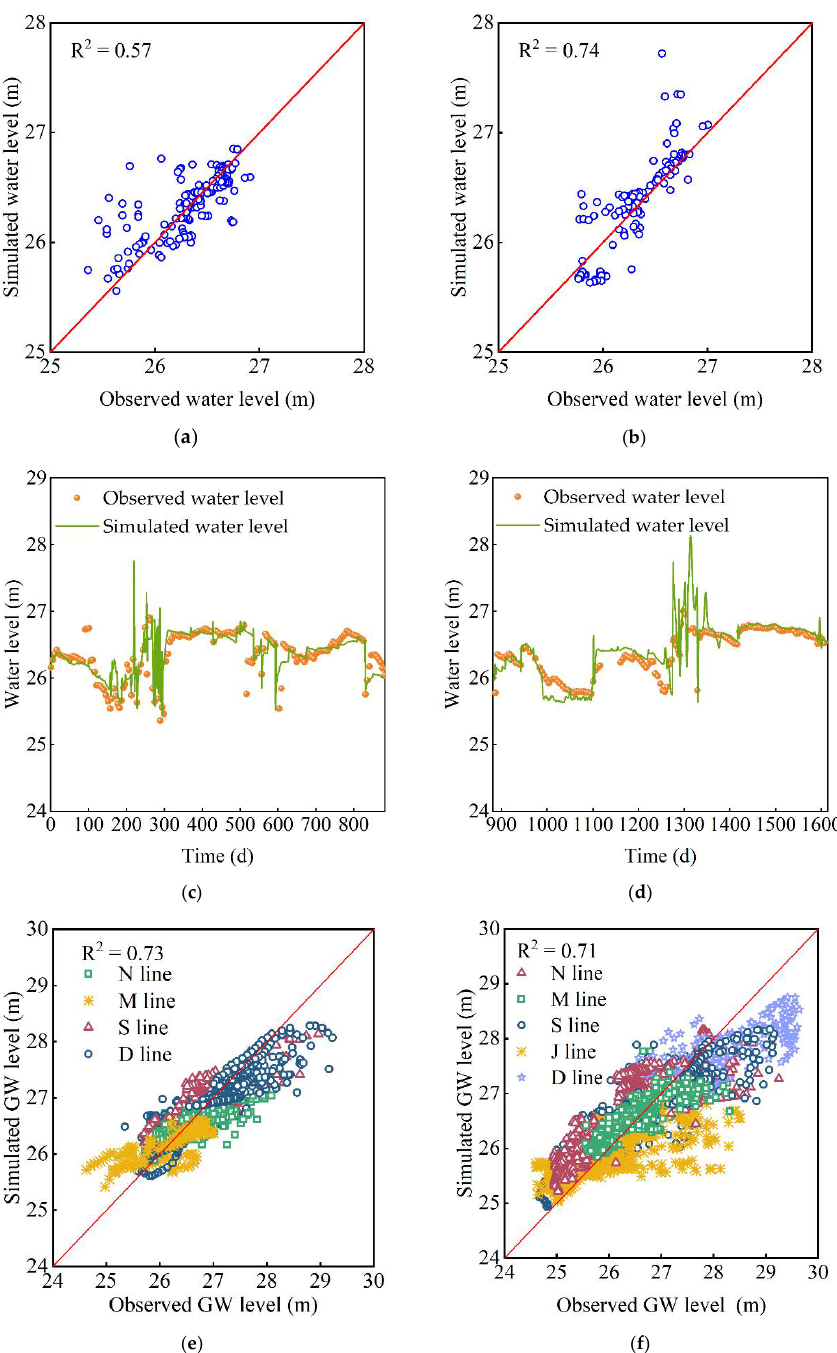
Figure 3. Simulation of groundwater level and main ditch water level in the study area during calibration period and validation period. Comparison of the main ditch levels during the calibration period ( a ) and the validation period ( b ). Comparison of measured and simulated water level in main ditch during the calibration period ( c ) and the validation period ( d ). Comparison of the groundwater levels during the calibration period ( e ) and the validation period ( f ).